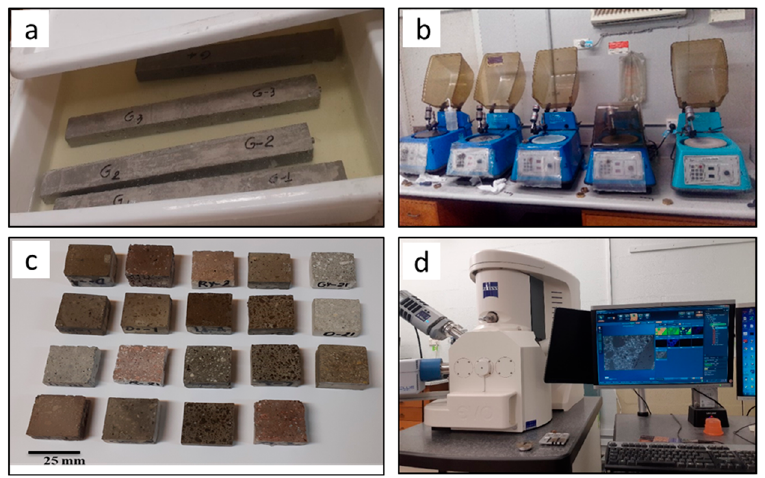
Figure 3. Preparing sample for SEM analysis: ( a ) mortar bars; ( b ) polishing equipment; ( c ) polished samples; ( d ) SEM facility.